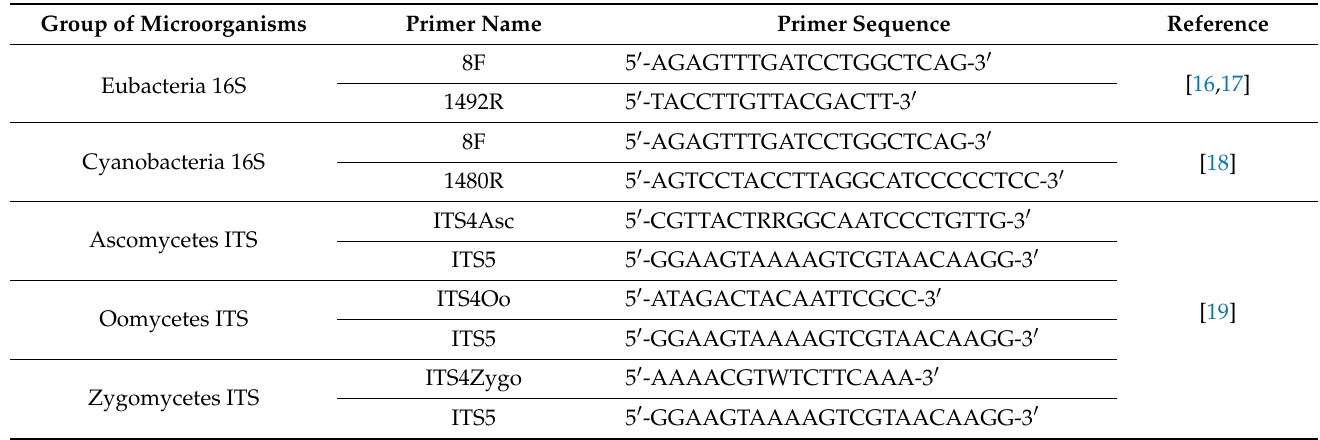
Table 1. Primers used PCR cloning of the 16S rDNA fragment from the bacterial strains and the ribosomal ITS fragment from fungal